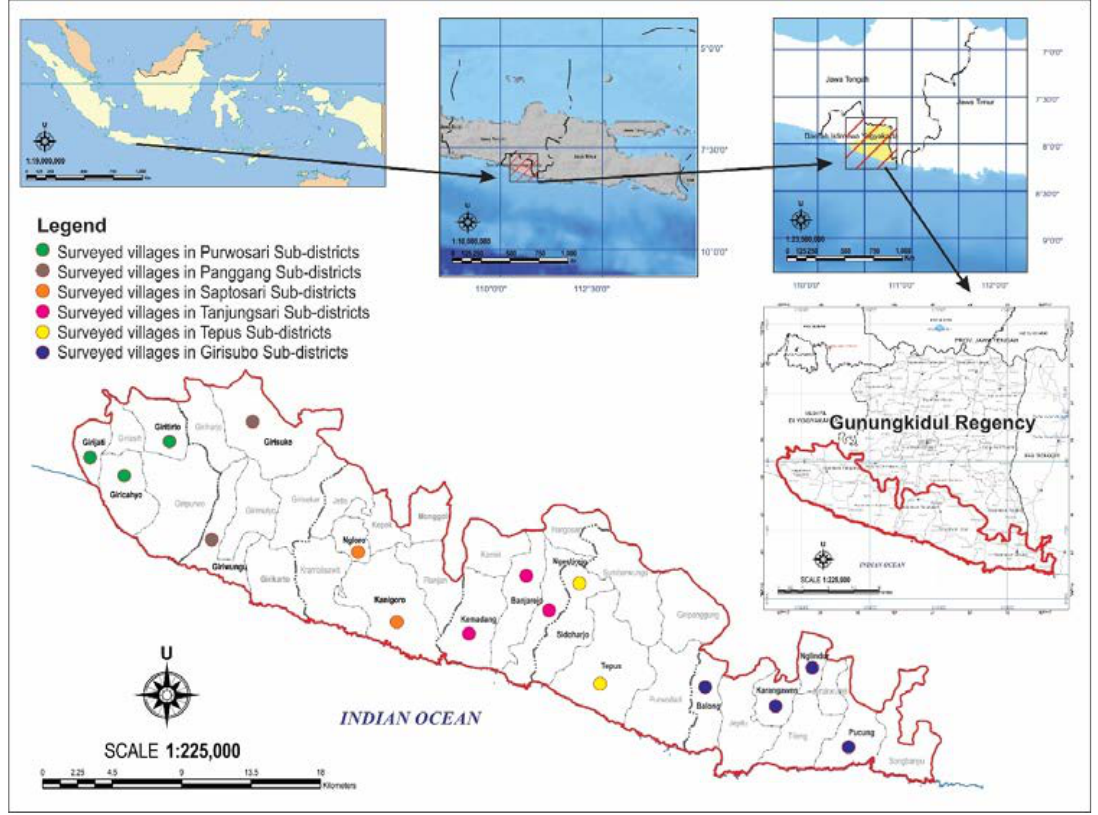
Fig. 1: Geographic location of the study area and surveyed villages in the southern zone of Gunungkidul Regency, in